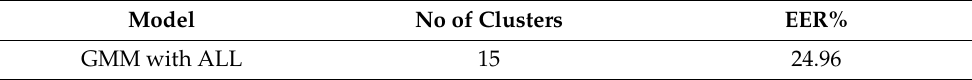
Table 5. Cont. Model No of Clusters EER% GMM with ALL 15 24.96